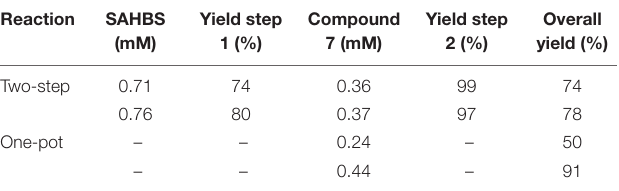
TABLE 2 | Bioconversion of MB9 using immobilised Escherichia coli KRX whole cells (120 mg DCW ml − 1 ) overproducing each enzyme separately (two-step) and overproducing both enzymes simultaneously